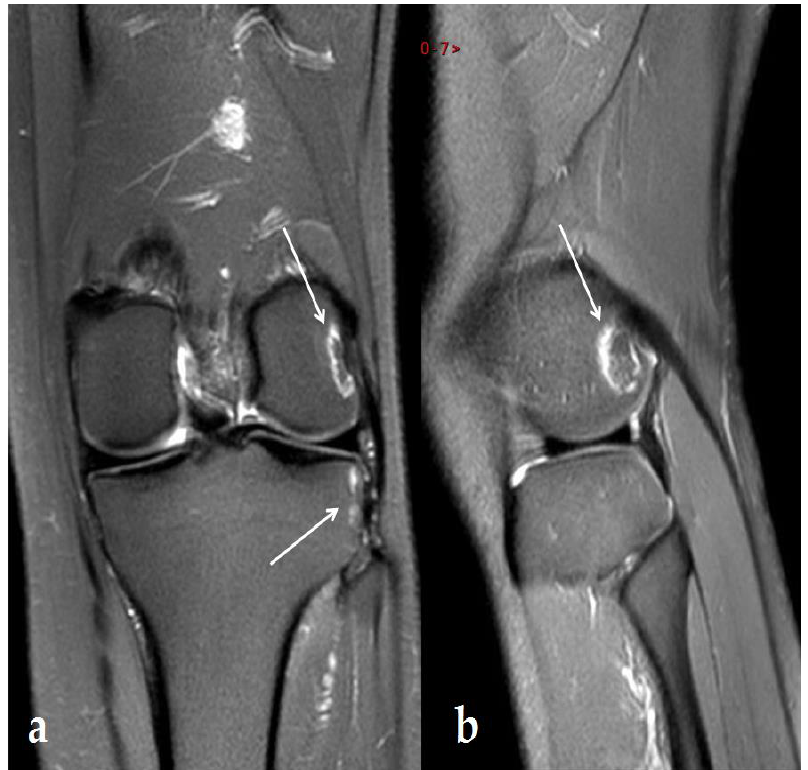
Figure 4. MRI: 6 months after the end of US therapy. DP FS MRI image in frontal ( a ) and sagittal ( b ) sections showing a reduction in lesions of the lateral femoral condyle, lateral tibial plateau, and head of the fibula with a sinuous cortical-to-cortical necrotic-like demarcation border in DP FS hypersignal 6 months after the US stopped. An 11 × 11 × 8 mm lesion remained on the femur and a 14 × 14 × 8 mm lesion on the tibia, but there was complete disappearance on the fibula. Arrows show